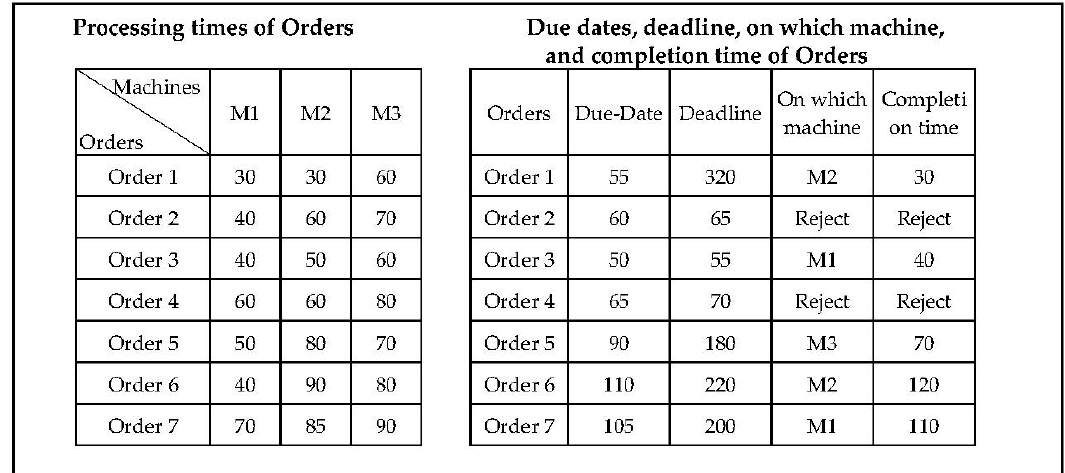
Figure 1. Procedure of the proposed IPBM.